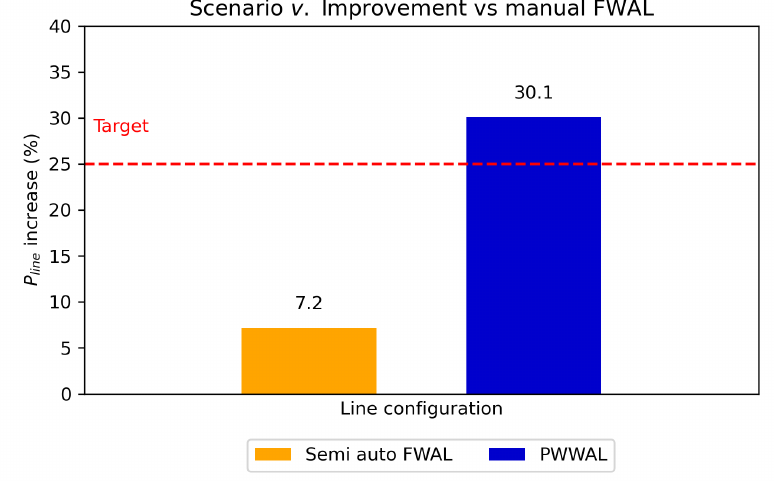
Figure 7. Line productivity improvement of semiautomated FW and parallel walking-worker with respect to manual FW line configuration under high-mix low-volume demand conditions ( scenario v